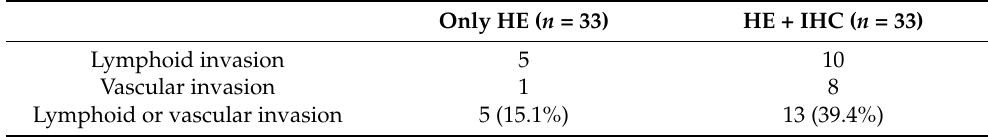
Table 2. The rate of LVI based on HE and IHC staining.